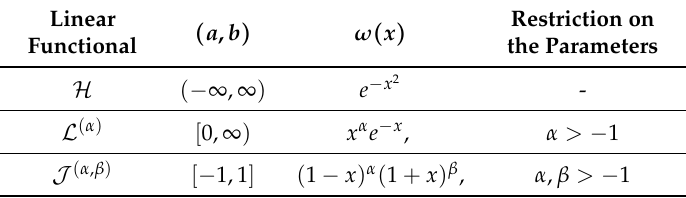
Table 2. Positive-definite classical orthogonal